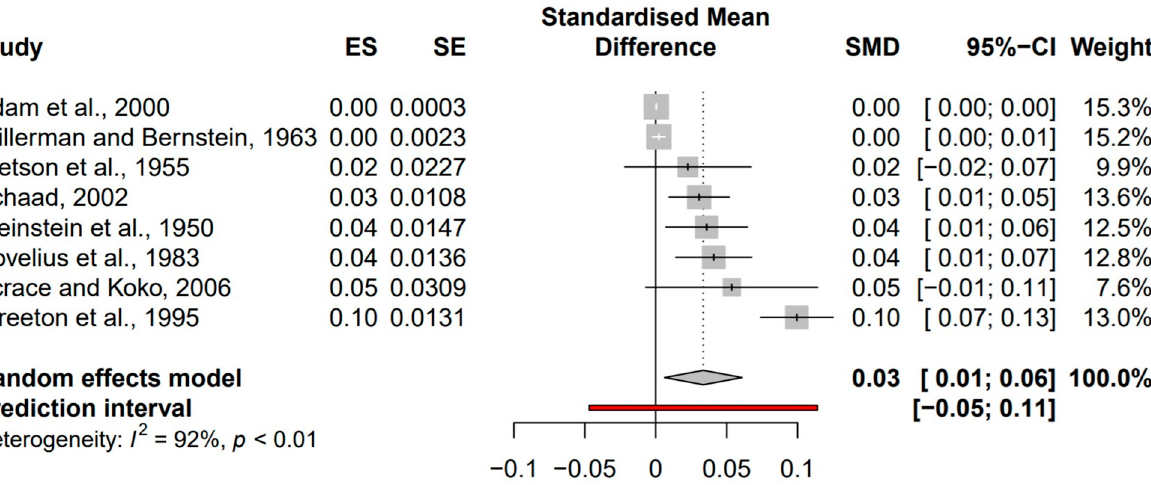
Figure 2. Lists the author and study year, effect size (ES), standard error (SE), standardized mean difference (SMD), and 95% confidence interval (CI) for each study. The forest plot reveals SMD for each study plotted against a random effects model.